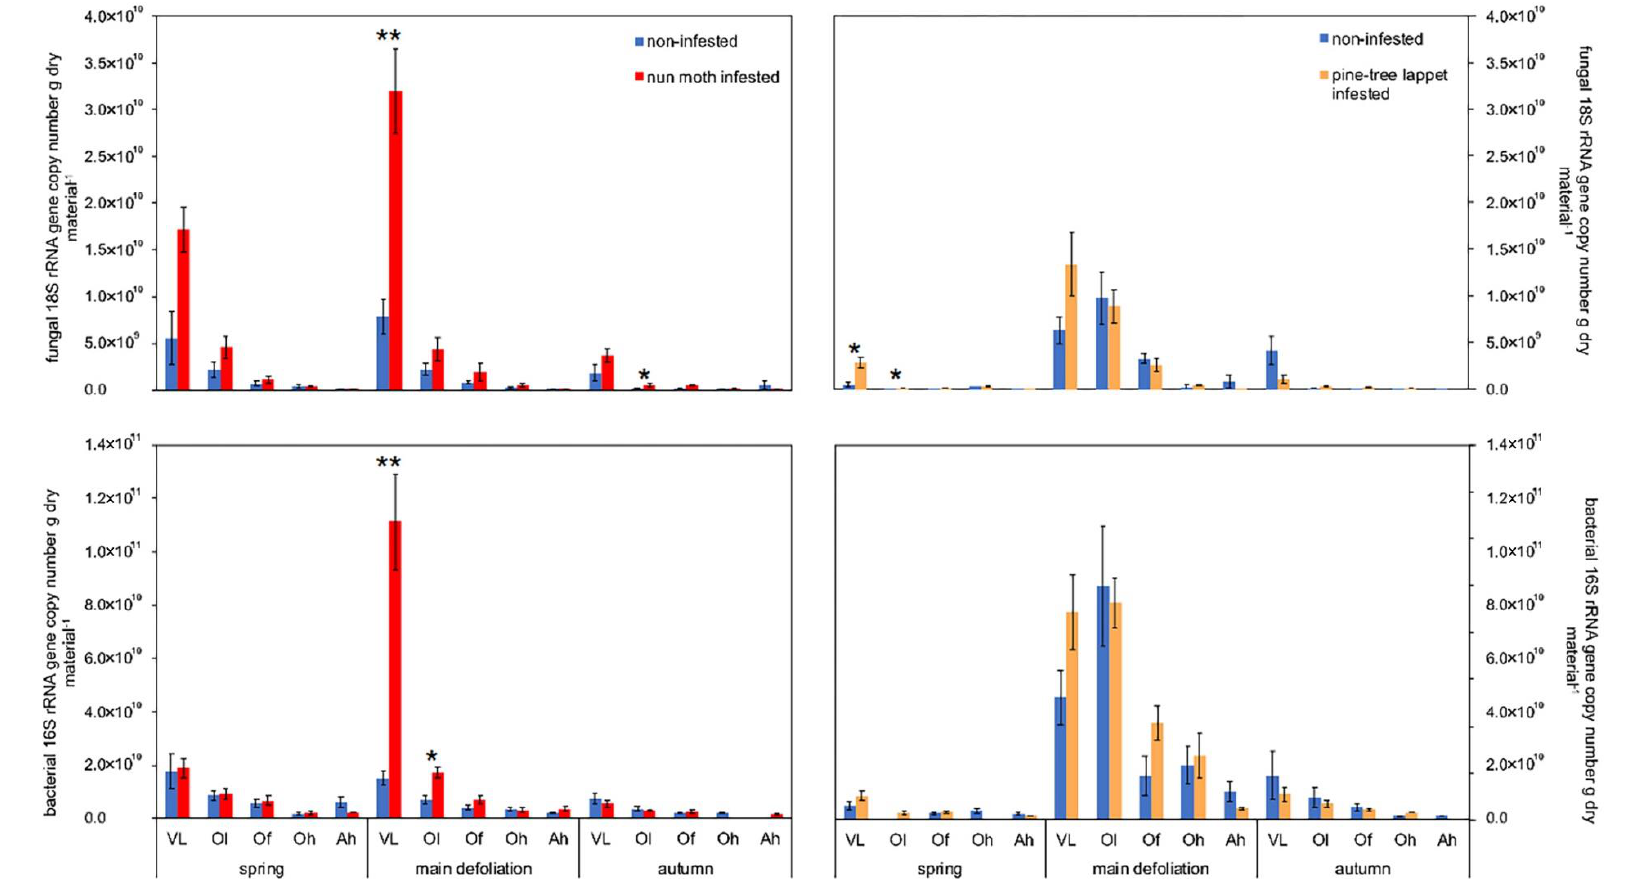
Figure 2. The mean fungal 18S rRNA and bacterial 16S rRNA gene copy numbers per gram of dry soil/plant material of the vegetation layers, organic layers, and the mineral soils of the nun moth ( Lymantria monacha L.) and pine-tree lappet ( Dendrolimus pini L.) infested and non-infested Scots pine ( Pinus sylvestris L.) forest sites. VL = vegetation layer, Ol = litter organic, Of = fibric organic, Oh = humic organic, Ah = humic mineral. The error bars represent the standard error of the mean with varying sample sizes (see Table A5); an asterisk indicates significant differences between the infested and non-infested site on the same sampling date and layer based on the Kruskal-Wallis test, ** p < 0.010, * p < 0.050).